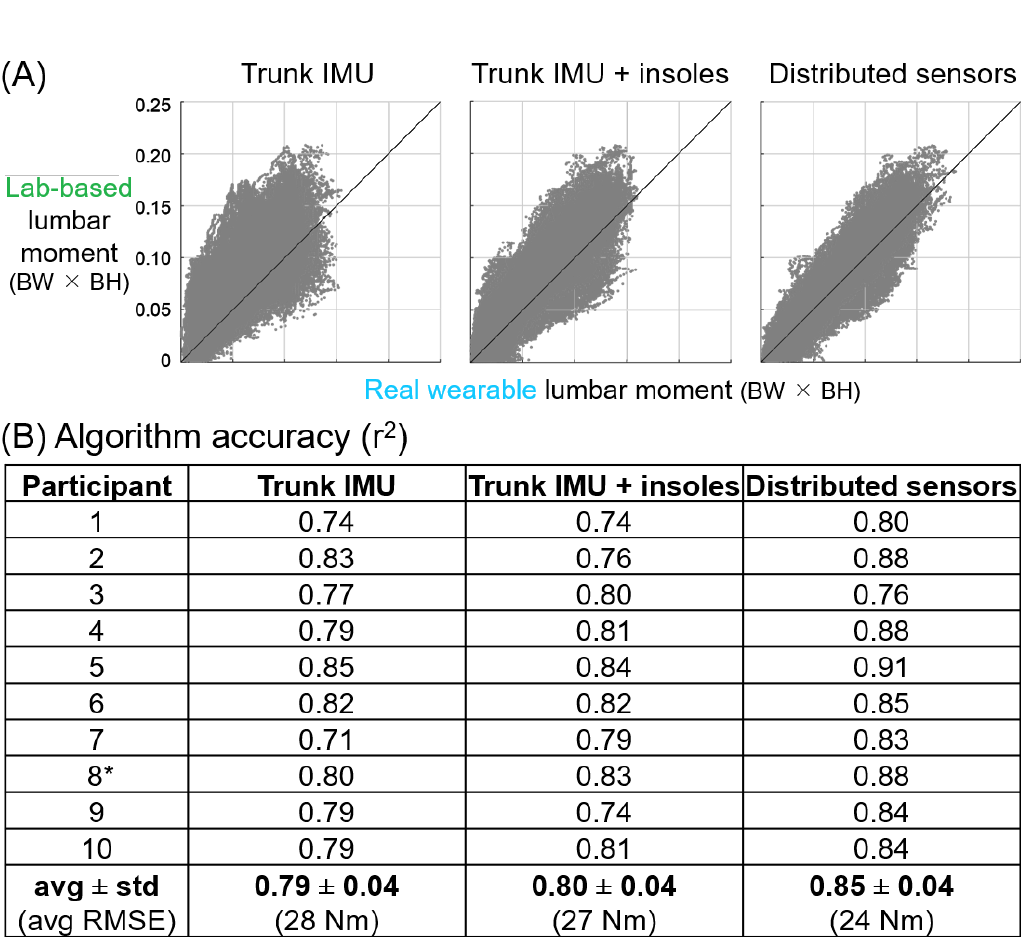
Figure 6. Algorithm accuracies for three different real wearable sensor combinations. ( A ) Lab-based (gold-standard) lumbar moment vs. real wearable sensor algorithm estimates of lumbar moment for all time samples for an example participant (participant 8*). Positive moments correspond to lumbar extension moments. A line with a slope of one is added to visualize a perfect correspondence between lab-based and wearable estimates. BW × BH = body weight × body height. ( B ) Coefficient of determination (r 2 ) for each participant. Both reduced sensor algorithms yielded accuracies that were lower than the distributed sensor combination ( p = 0.011 and p = 0.014 for the trunk IMU, and trunk IMU and insole algorithms, respectively; based on Wilcoxon signed-rank test of the k-fold cross validation accuracy results), but the accuracy of the two reduced sensor algorithms shown here were not different from each other ( p = 0.571).